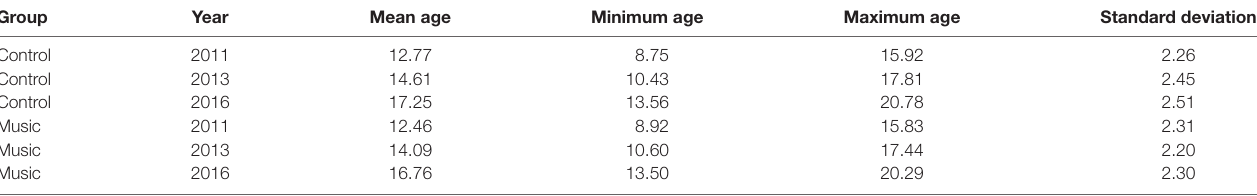
TABLE 1 | Ages of participants in the Music and Control groups per measurement year for the Digit Span Test. Group